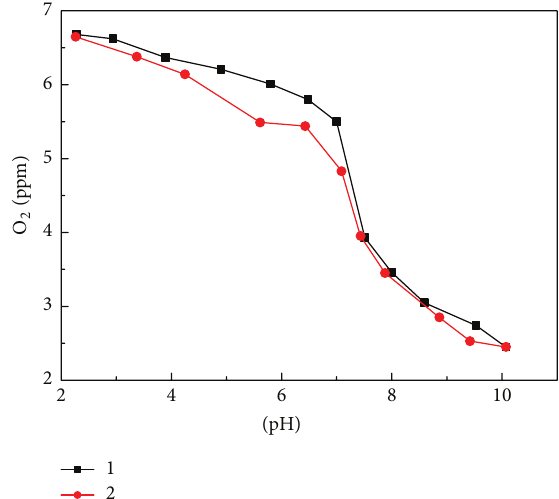
Figure 8: Evolution of dissolved oxygen concentration as a function of solution pH ( 𝐶 DABA = 1.2 × 10 −3 mol ⋅ dm −3 , 𝐶 Co ( II ) = 6.0 × 10 −4 mol ⋅ dm −3